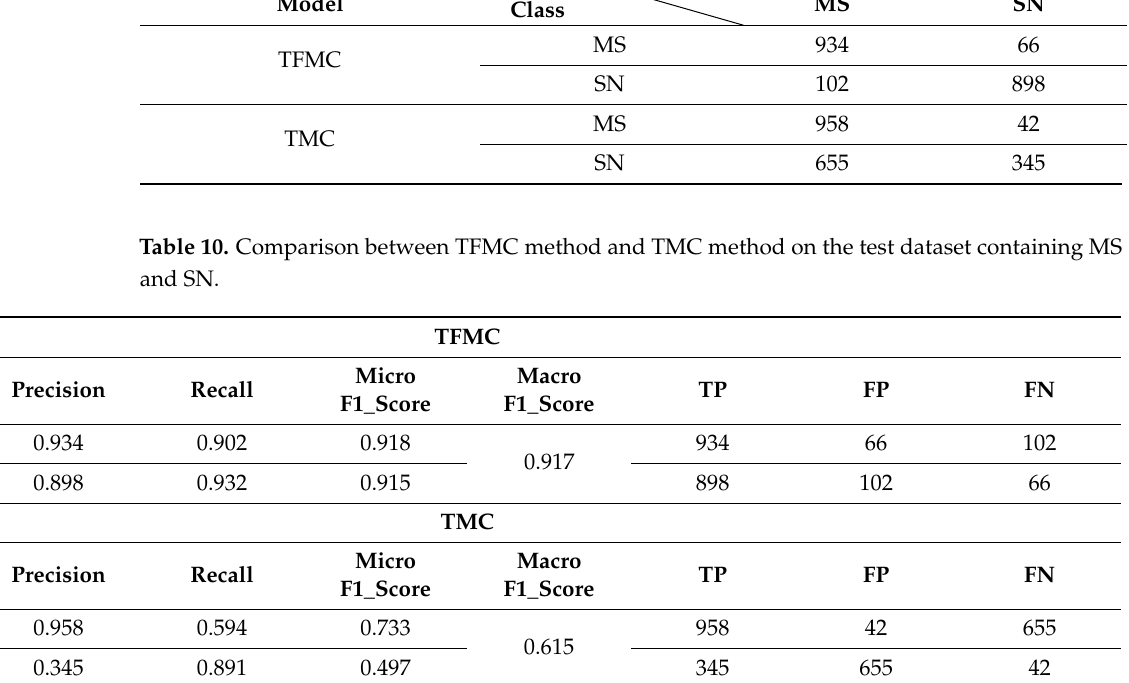
Table 9. Comparison of TFMC method and TMC method on the dataset of MS and SN. Prediction Model Class